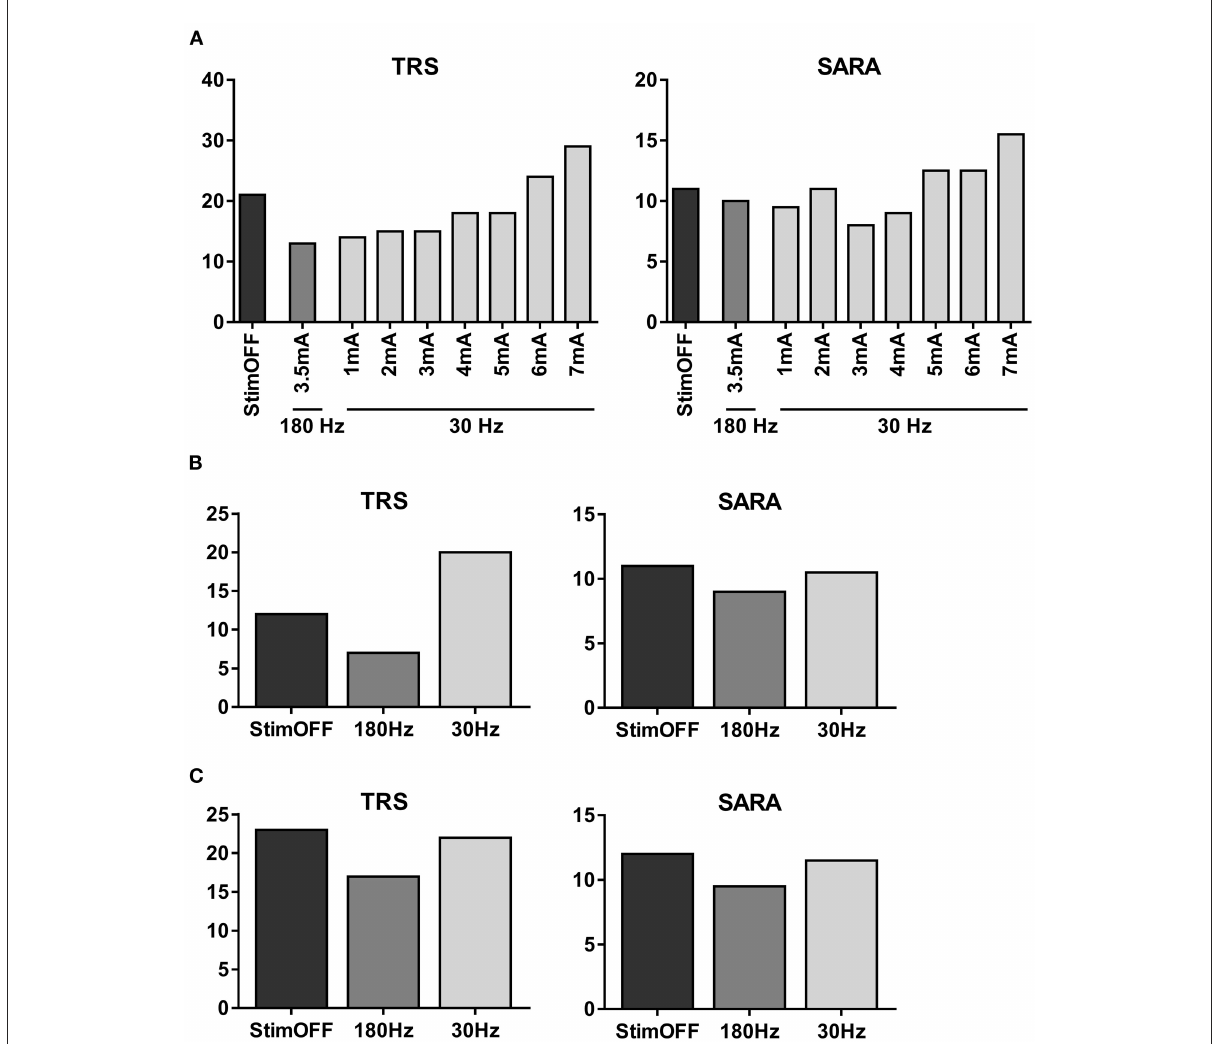
FIGURE4 Clinical tremor and ataxia scores assessed with different stimulation paradigms. (A) In the immediate assessment, TRS and SARA were scored with StimOFF, 180 Hz-stimulation of the 2nd-lowermost (VIM) contacts and 30Hz stimulation of the lowermost (subthalamic) contacts with increasing amplitudes from 1 to 7mA in a randomized order. (B) The first follow-up examination was scheduled 5 weeks from baseline with preceding 180Hz-stimulation (3.5mA) at daytime and 30 Hz stimulation (4 mA) at night. (C) The second follow-up was scheduled 10 weeks from baseline with preceding 180 Hz-stimulation (3.5mA) at daytime and StimOFF at night. For all assessments, the rater and patient were blinded to the respective previous stimulation